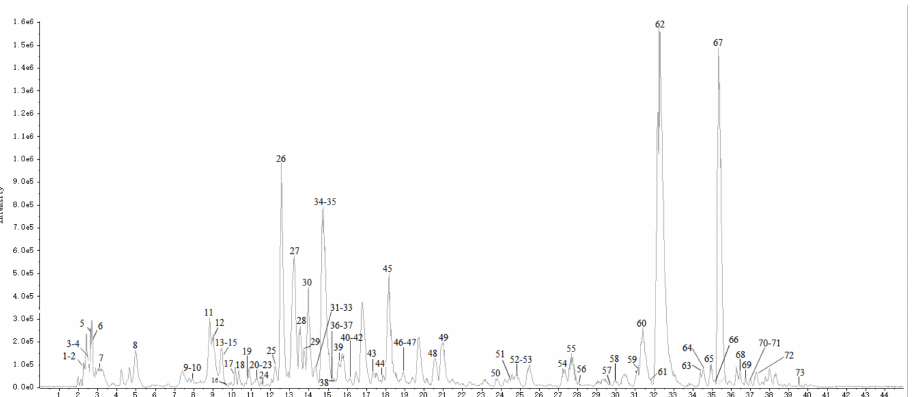
Figure 1. The base peak chromatogram (BPC) of Taxilli Herba from Morus alba L. in negative ion